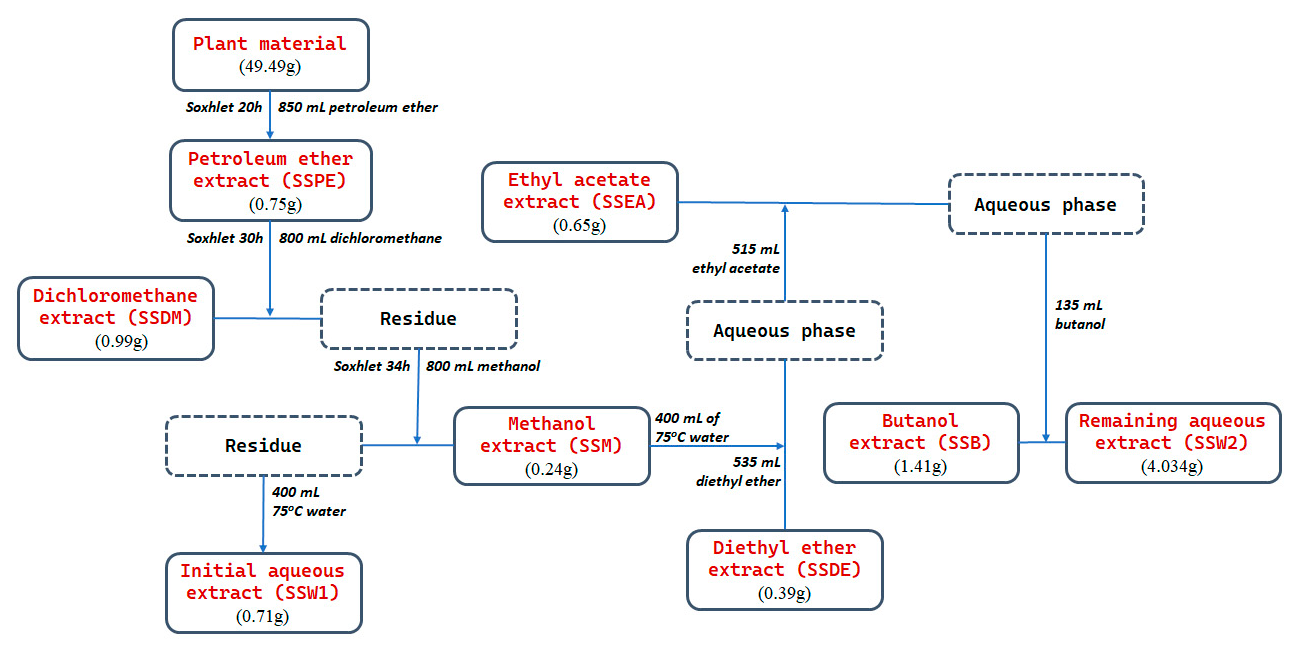
Figure 6. Graphical representation of the plant extraction process leading to the generation of eight distinct SS extracts. distinct SS